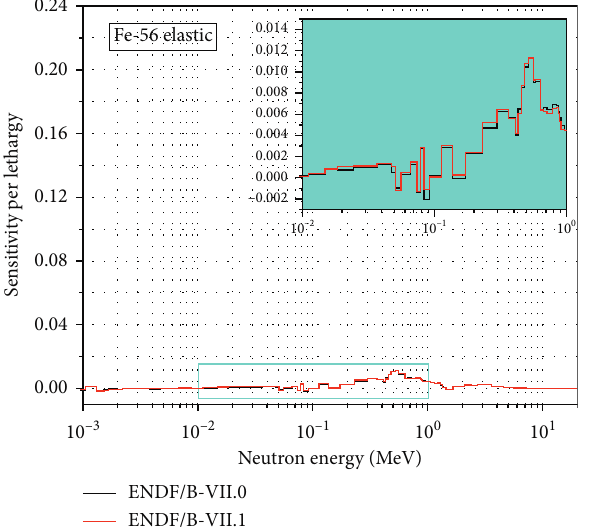
to 208 Pb elastic eff